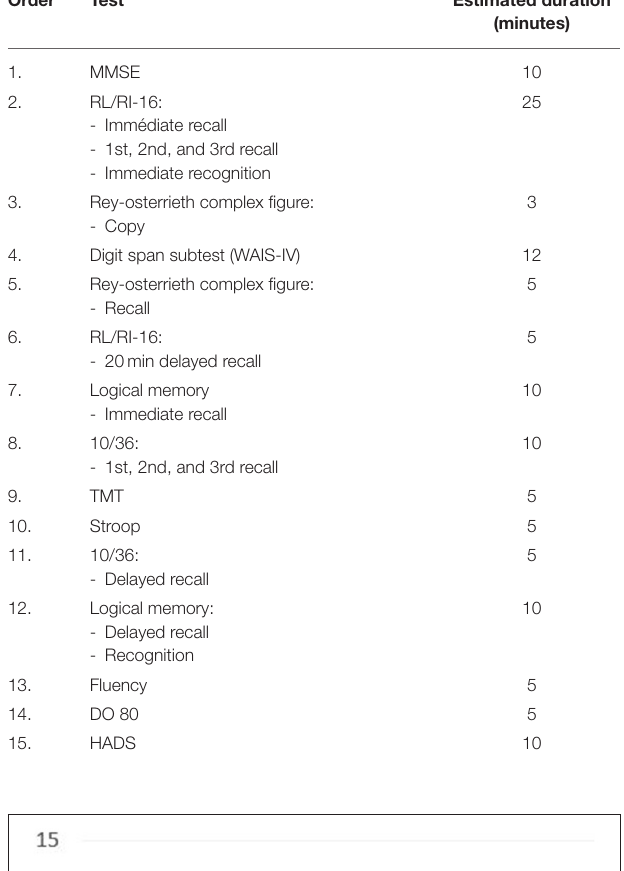
TABLE 2 | Order of tests